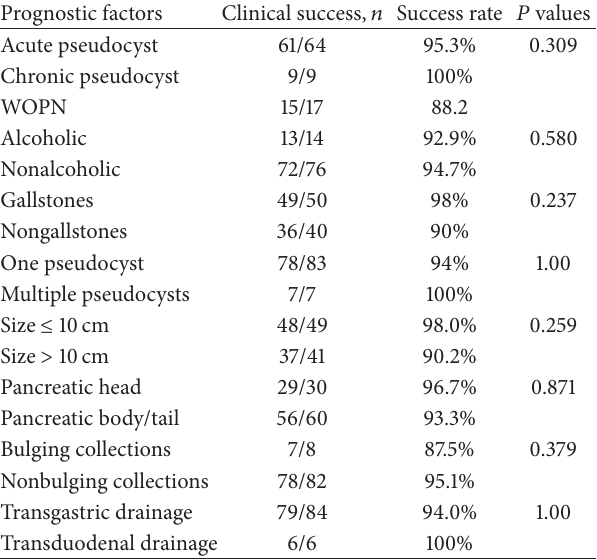
Table 2: The treatment success rate in PFCs with different charac- teristics.